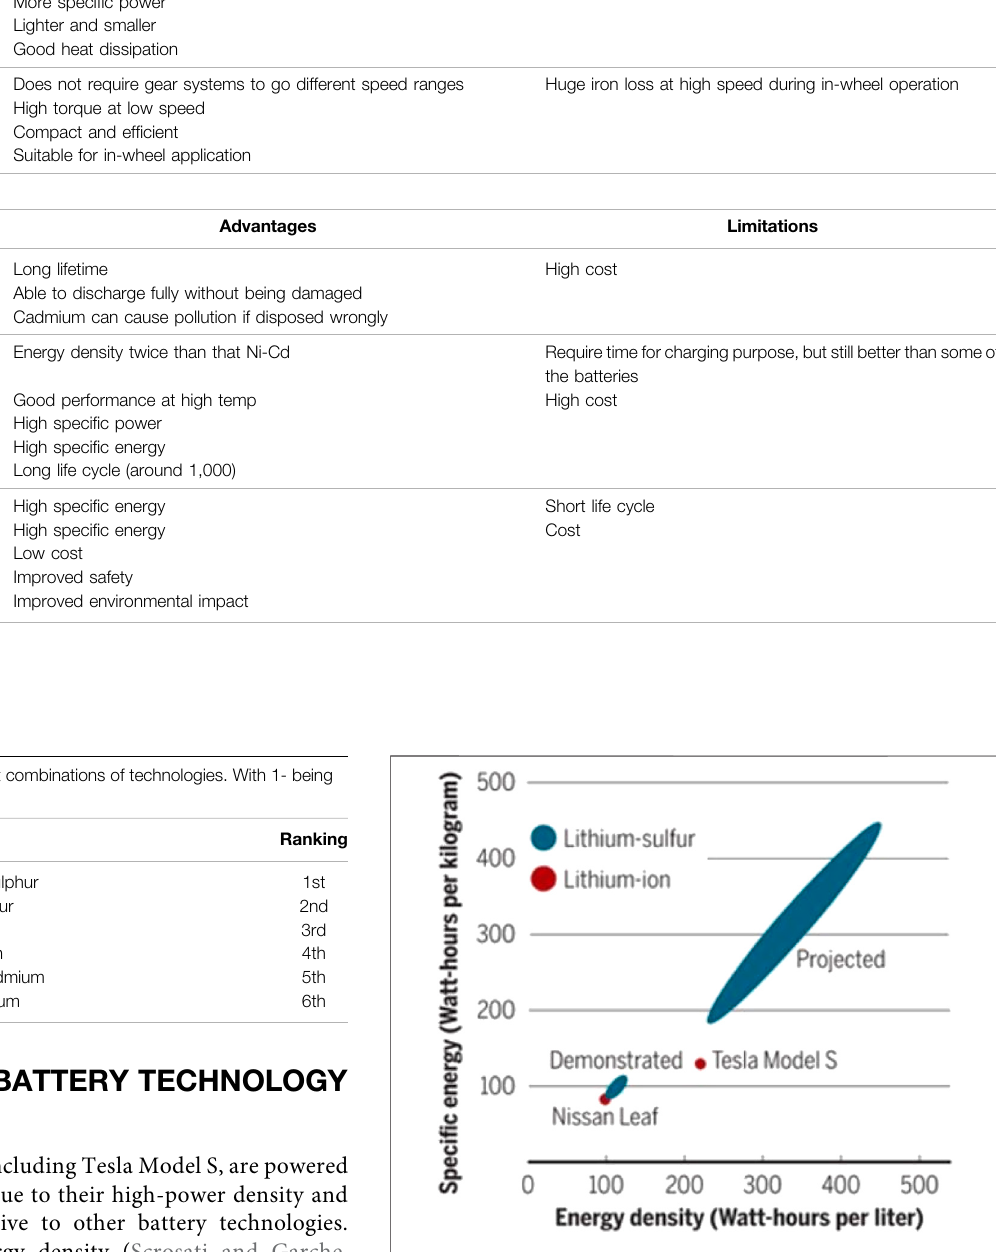
FIGURE 12 | Comparison of Li-S and Li-ion batteries. Adapted from (Manthiram et al., 2014).